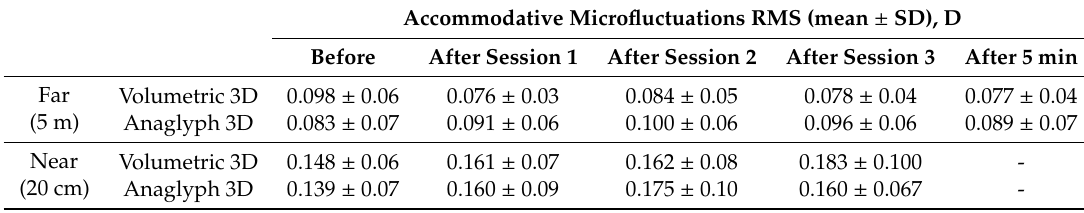
Table 3. Accommodative microfluctuations expressed as mean RMS value ( ± SD) for near, and far, distances in each session for volumetric 3D and anaglyph